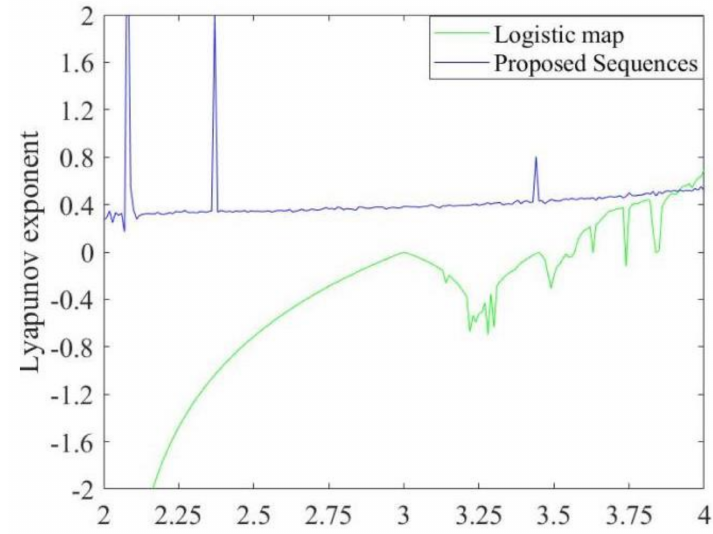
Figure 6. Lyapunov exponent of x -dimensional proposed sequence and Equation (1).